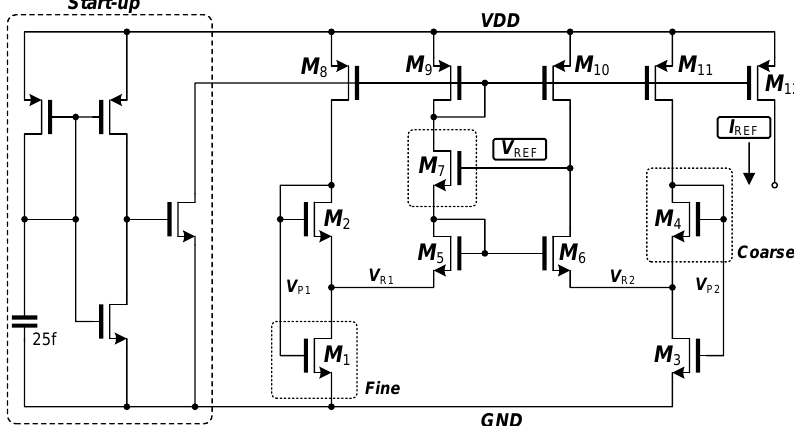
Figure 10. Schematic of the reference current and voltage generator.